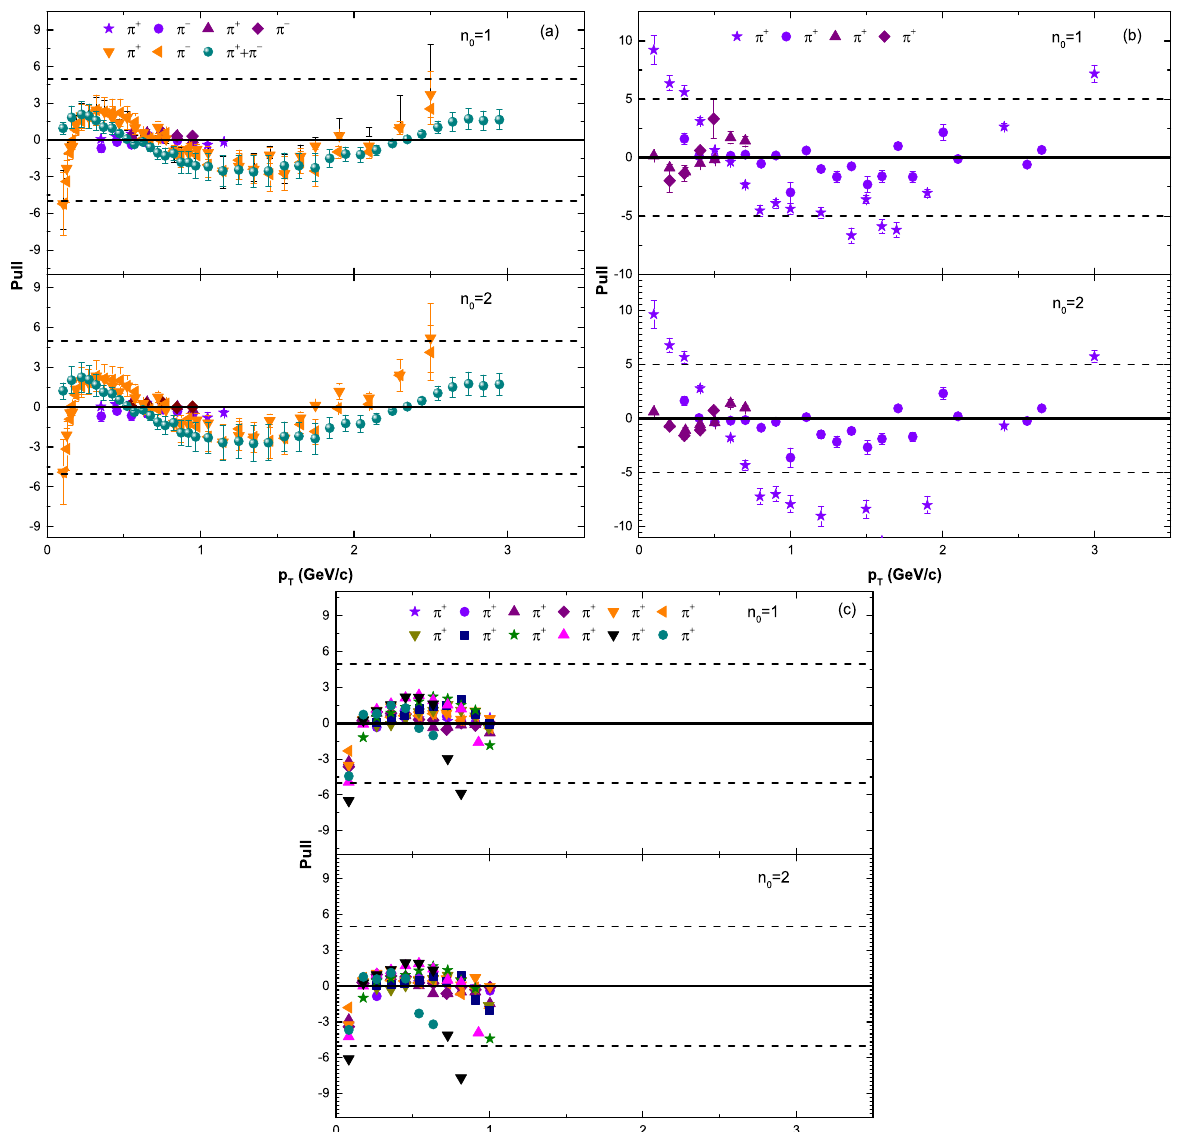
Figure 1. The invariant p T spectra of π + ( π − )( π + + π − ) measured in inelastic pp collisions. Panel ( a ) represents the transverse momentum spectra of pion at 6.3, 17.3, 900 and 7000 GeV collision energies, while panels ( b ) and ( c ) show the transverse momentum spectra of pion in y = 0–2.3 rapidity slices at 31 GeV. The symbols are the experimental data of NA61/SHINE [57,58] and ALICE Collaborations [59,60], and the curves are our fit results by the blast-wave model with Tsallis statistics based on Equation (1). The solid curves are the fit results by interpreting n 0 = 1 in TBW model, while the dashed curves are the results of the fit by using n 0 = 2 in Equation (1). The spectra at 6.3 and 17.3 GeV for π − for both n 0 = 1 and 2 in are scaled by a factor of 1/4 and 1.2, respectively. Similarly, the spectra of π + and π − at 900 GeV are scaled by the factor 1.5 and 5, respectively, and the spectra at 7000 TeV is scaled by a factor of 8. The spectra of π + at 31 GeV in rapidity slices y = 1 and 1.4 are scaled by 1/5 and 1/10, respectively. The corresponding data/fit ratios of the fits in upper panels are followed in their lower panels. The filled and open symbols in the data/fit ratios represent the results from the model with n 0 = 1 and n 0 = 2, respectively. The method of least squares is used in the fit for extracting the related parameters. ( a ) Represents the pull distributions of Figure 1 by the TBW model with n 0 = 1 (upper part of each panel) and n 0 = 2 (lower part of each